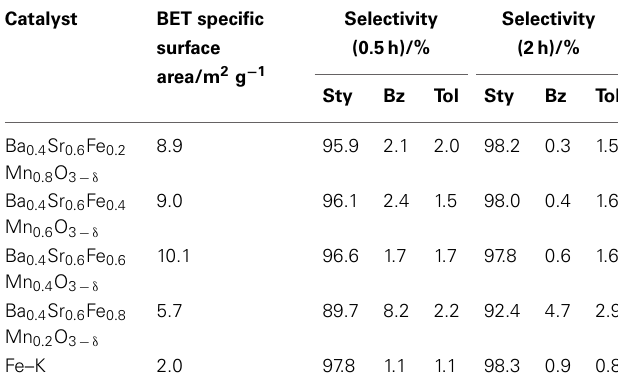
Table 5 | Selectivity to styrene, benzene, and toluene on EBDH